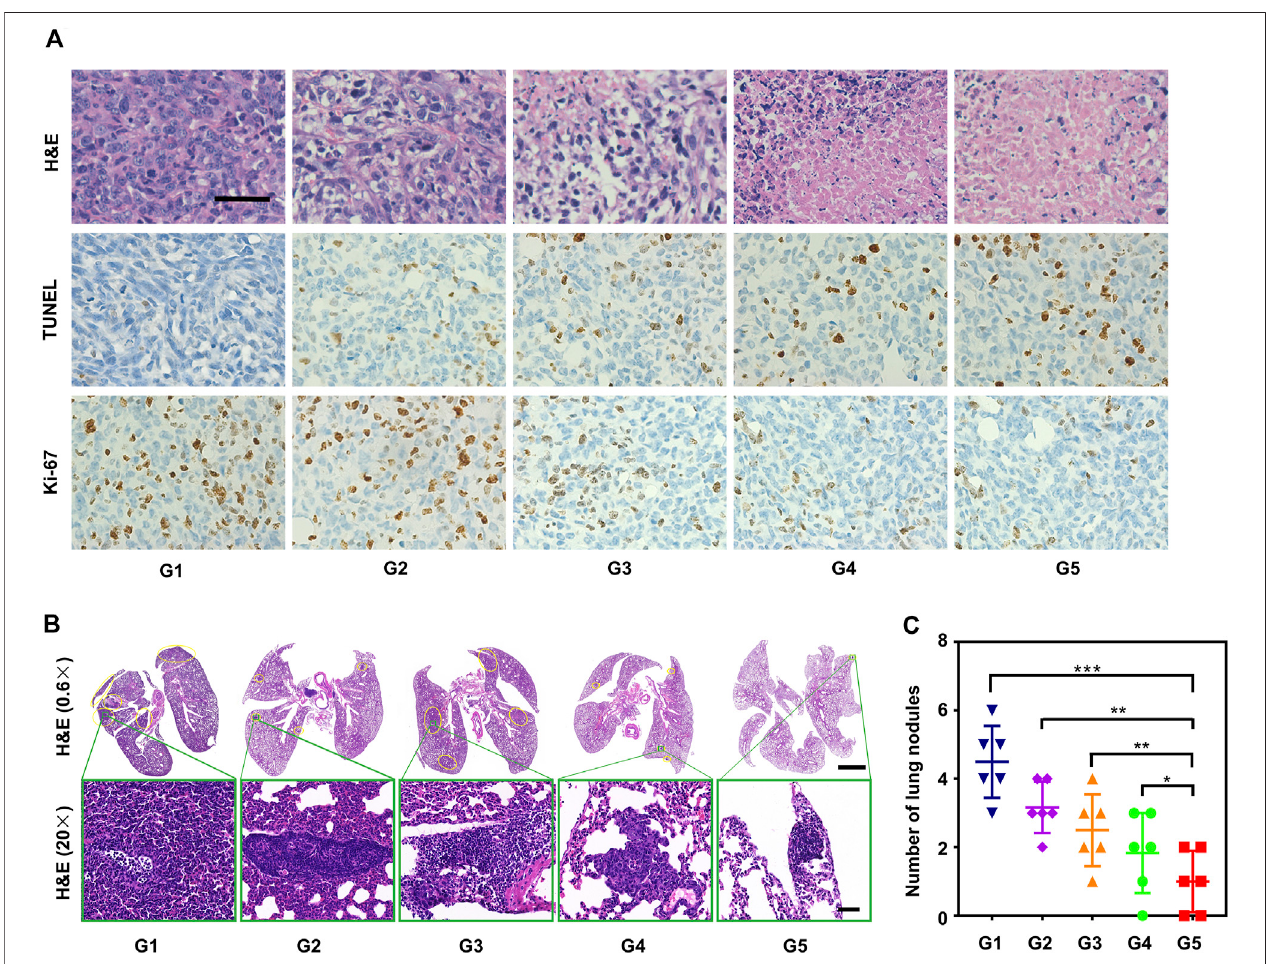
FIGURE 8 | In vivo study of the antitumor and anti-metastasis effect of synergistic cascade strategy. (A) Hematoxylin and eosin (H&E) staining, Ki-67 staining, and TUNEL staining images of tumor tissue after different treatments (G1 – G5) for 18 days. Scale bars represent 50 μ m. (B) H&E staining of lung metastatic sites (yellow borders) of 4T1 tumors. Scale bars represent 2,000 μ m for 0.6 × and 50 μ m for 20 × , respectively. (C) The number of pulmonary metastatic nodules after various treatments (G1 – G5) was calculated according to H&E staining results. The data are presented as mean ± SD ( n (cid:2) 6, ** p < 0.01, *** p < 0.001).